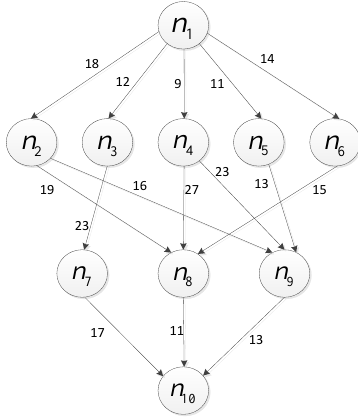
Figure 1. An example of a directed acyclic graph (DAG)-based parallel application with ten tasks. Table 2. Execution time of tasks on different processors with the maximum frequency of the application in Figure 1.